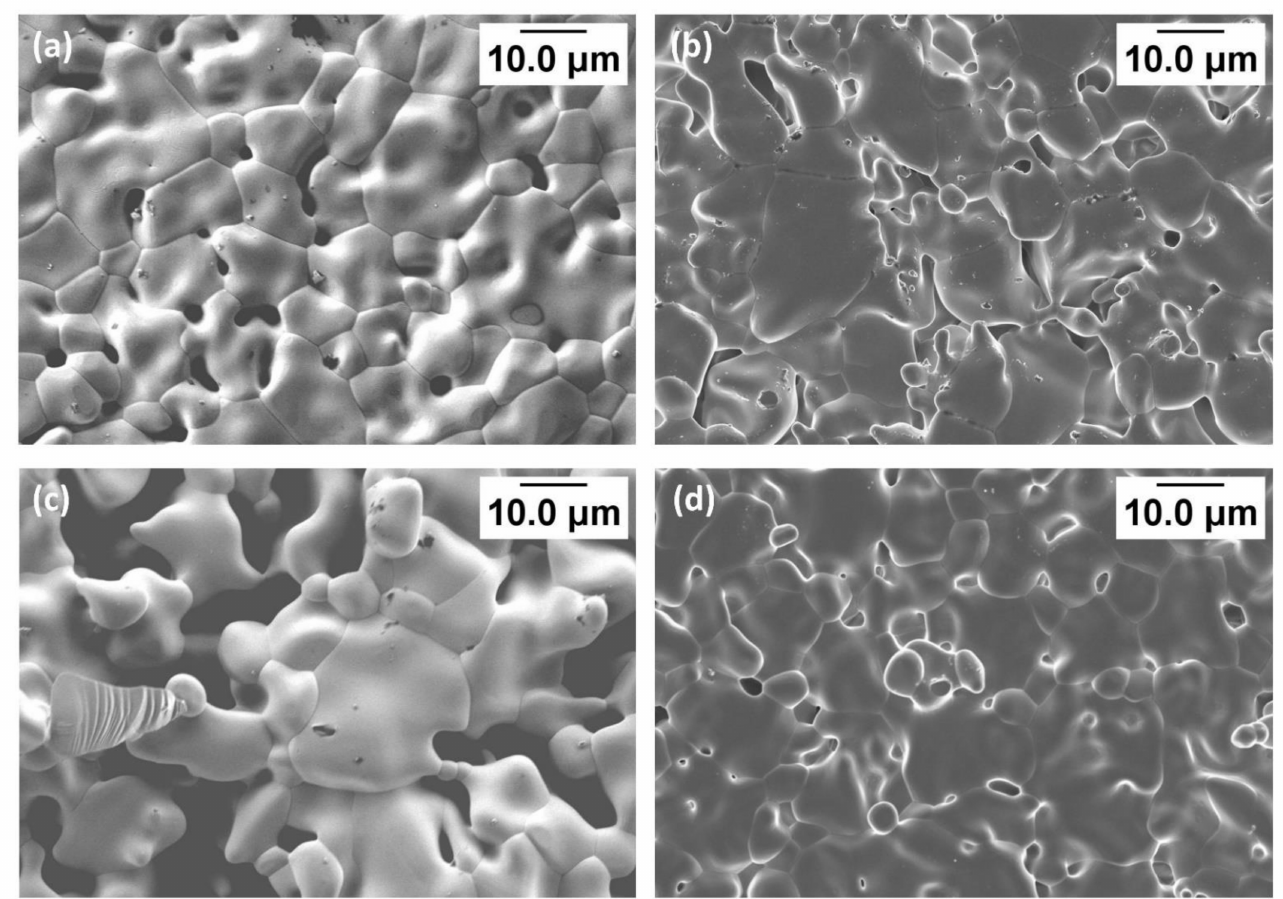
Figure 4. SEM micrographs for ( a ) 0.5 W; ( b ) 1.0 W; ( c ) 1.25 W and ( d ) 1.5 W with grain and grain